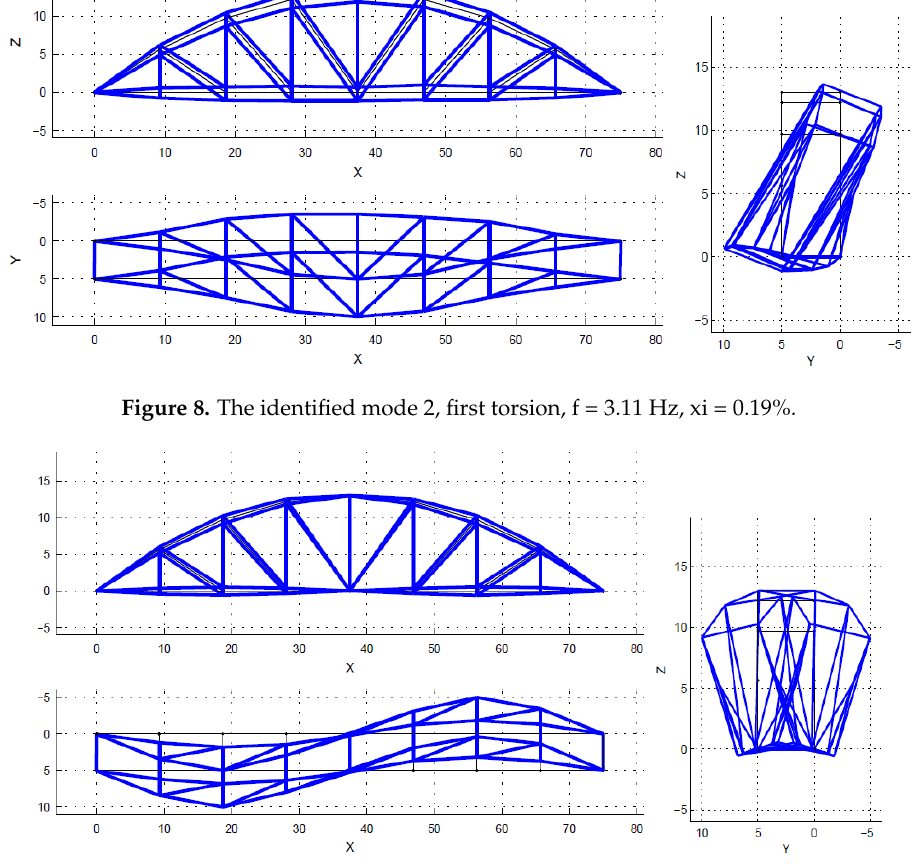
Figure 9. The identified mode 3, second lateral, f = 3.28 Hz, xi = 0.27%.